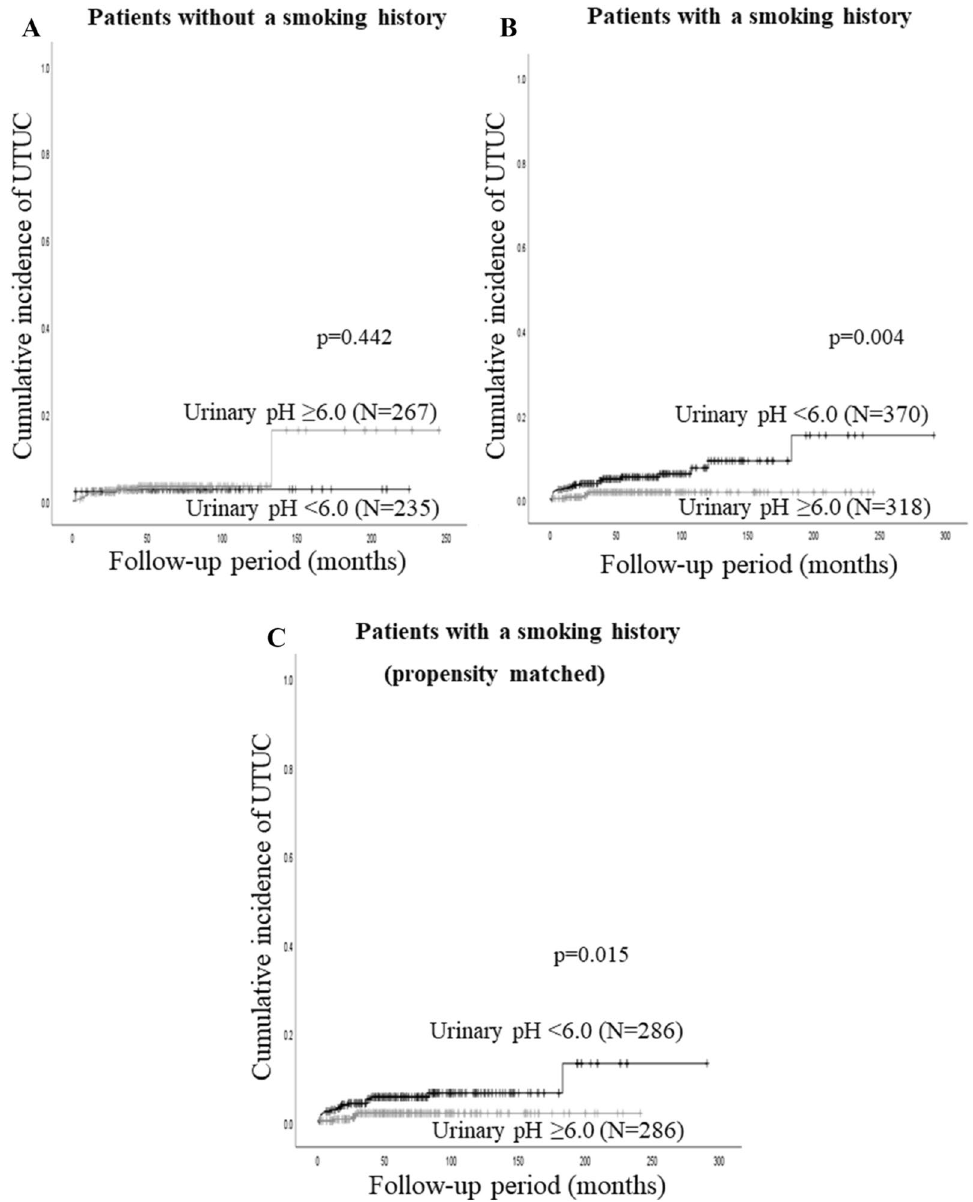
Figure 2. Cumulative incidence of UTUC recurrence stratified by urinary pH levels in ( A ) NMIBC patients without a smoking history, ( B ) those with a smoking history before a propensity matching analysis and ( C ) those with a smoking history after a propensity matching